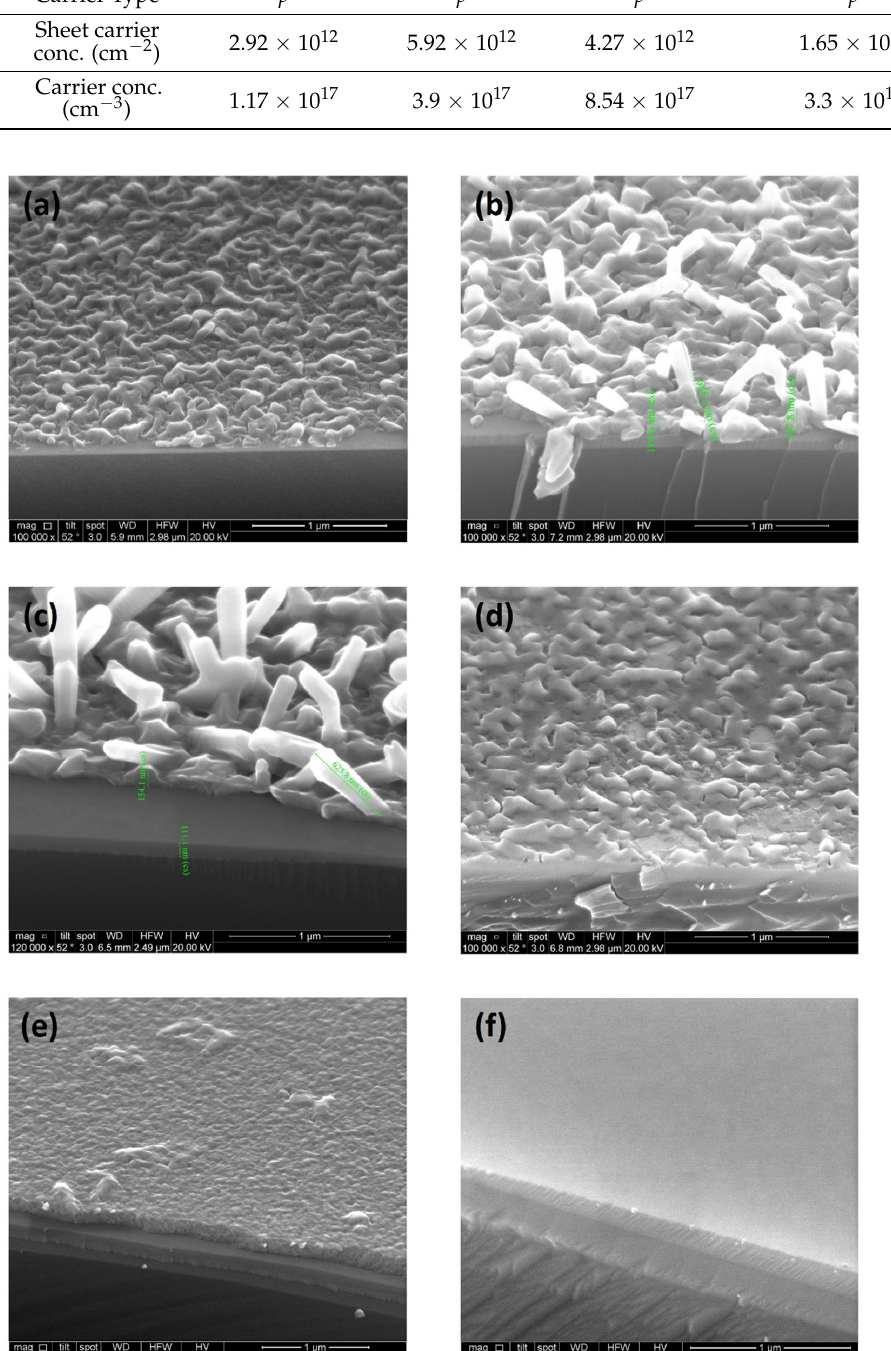
Figure 1 . SEM images: ( a ) 50 nm GaSb on SiO 2 , ( b ) 150 nm GaSb on SiO 2 , ( c ) 250 nm GaSb on SiO 2 , ( d ) 50 nm GaSb on SI GaAs, ( e ) 50 nm GaAs + 50 nm GaSb on SiO 2 , and ( f ) 50 nm GaAs + 50 nm GaSb on SI GaAs. All scale bars are 1 µm.